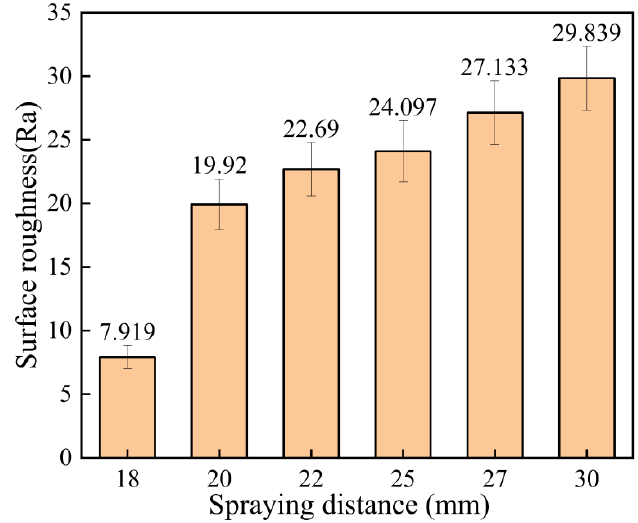
Figure 9. Surface roughness of the coating at different spraying distances.